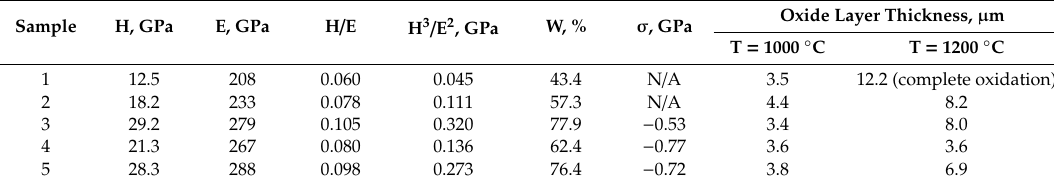
Table 2. Mechanical and chemical properties of coatings.